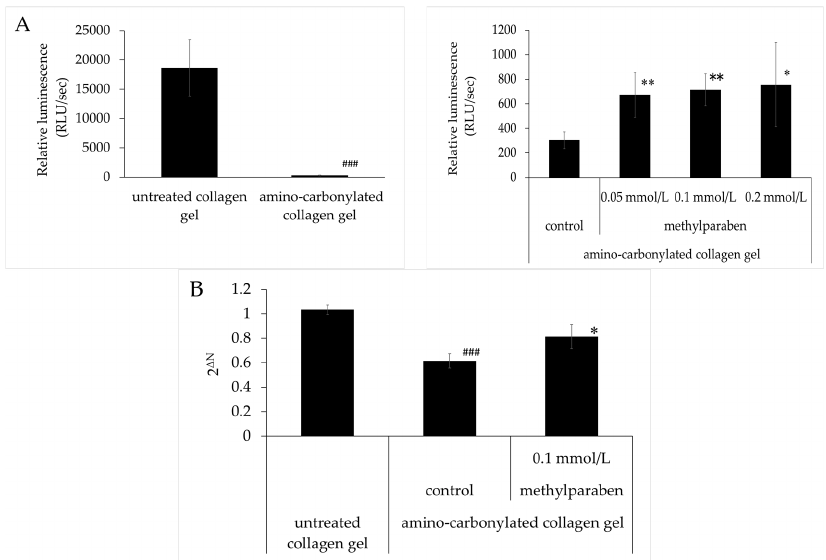
Figure 5. E ffect of methylparaben on the decreases in ATP and filaggrin mRNA levels in HaCaT cultured on amino-carbonylated collagen gel. ( A ) ATP levels in amino-carbonylated collagen gel in